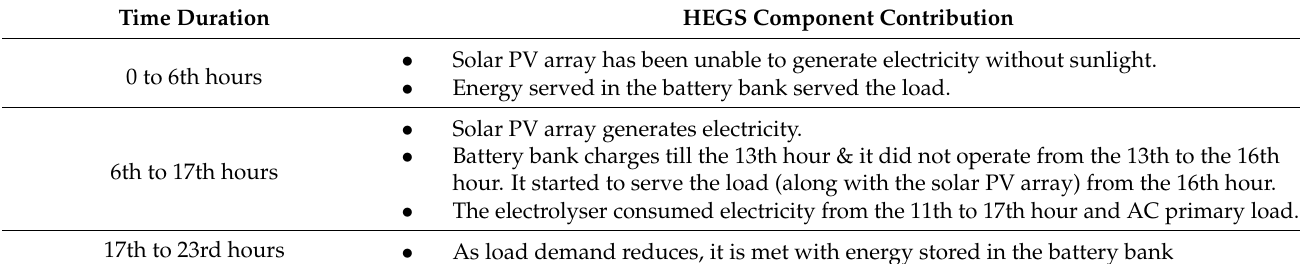
Table 7. Time series analysis for the 2nd day of January.